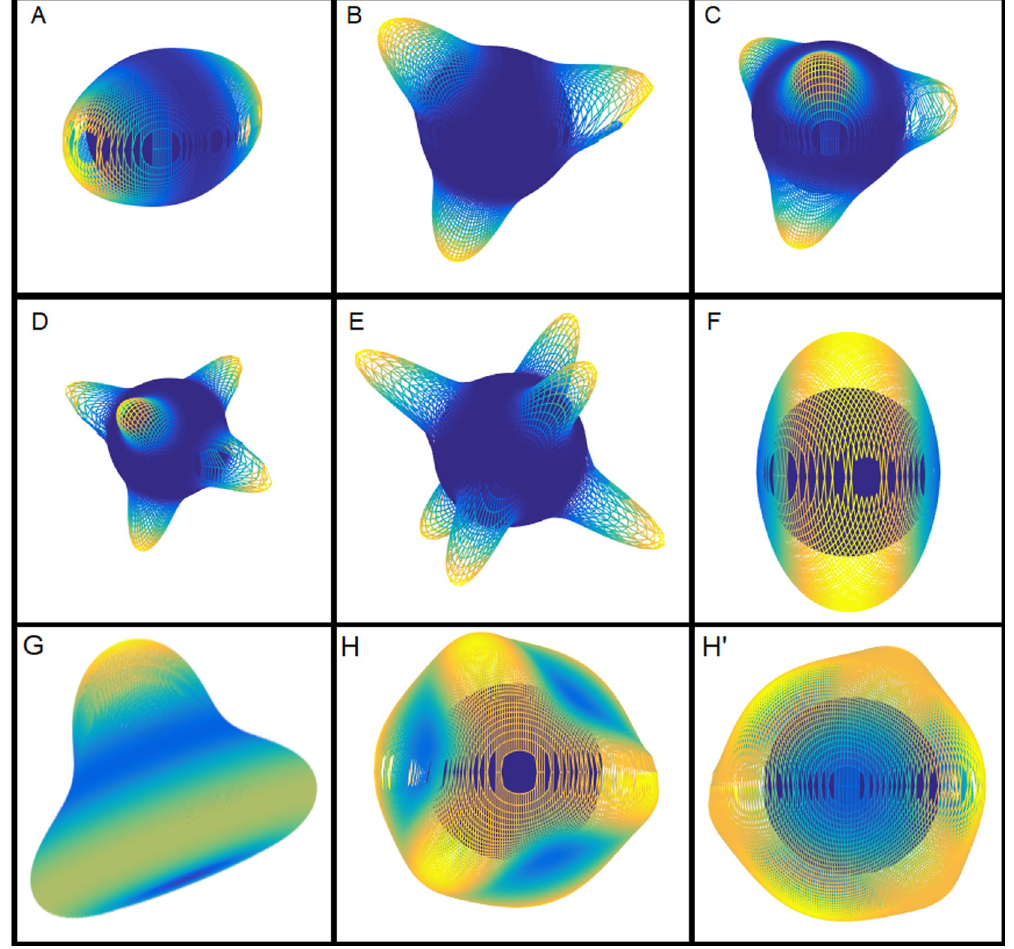
Fig 7. Examples of the different patterns the model simulated on a sphere was able to produce when varying the kinetics. In 3D, the following patterns were commonly observed: (A) two spikes on opposite poles, (B) three spikes equally spaced along a great circle, (C) four spikes located on the corners of a tetrahedron, (D) five spikes, (E) six spikes, with four spikes equally spaced along a great circle and the remaining two spikes on the poles, (F) a ring-like pattern with increased morphogen concentration along a great circle, (G) a single spike and a ring-like pattern, and (H,H’) six elongated spikes located on the edges of a tetrahedron. In the 3D plots, the activator concentration is represented by the height from the initial surface of the sphere (dark blue), color-coded from blue (almost no activator) to yellow (the highest amount of activator).